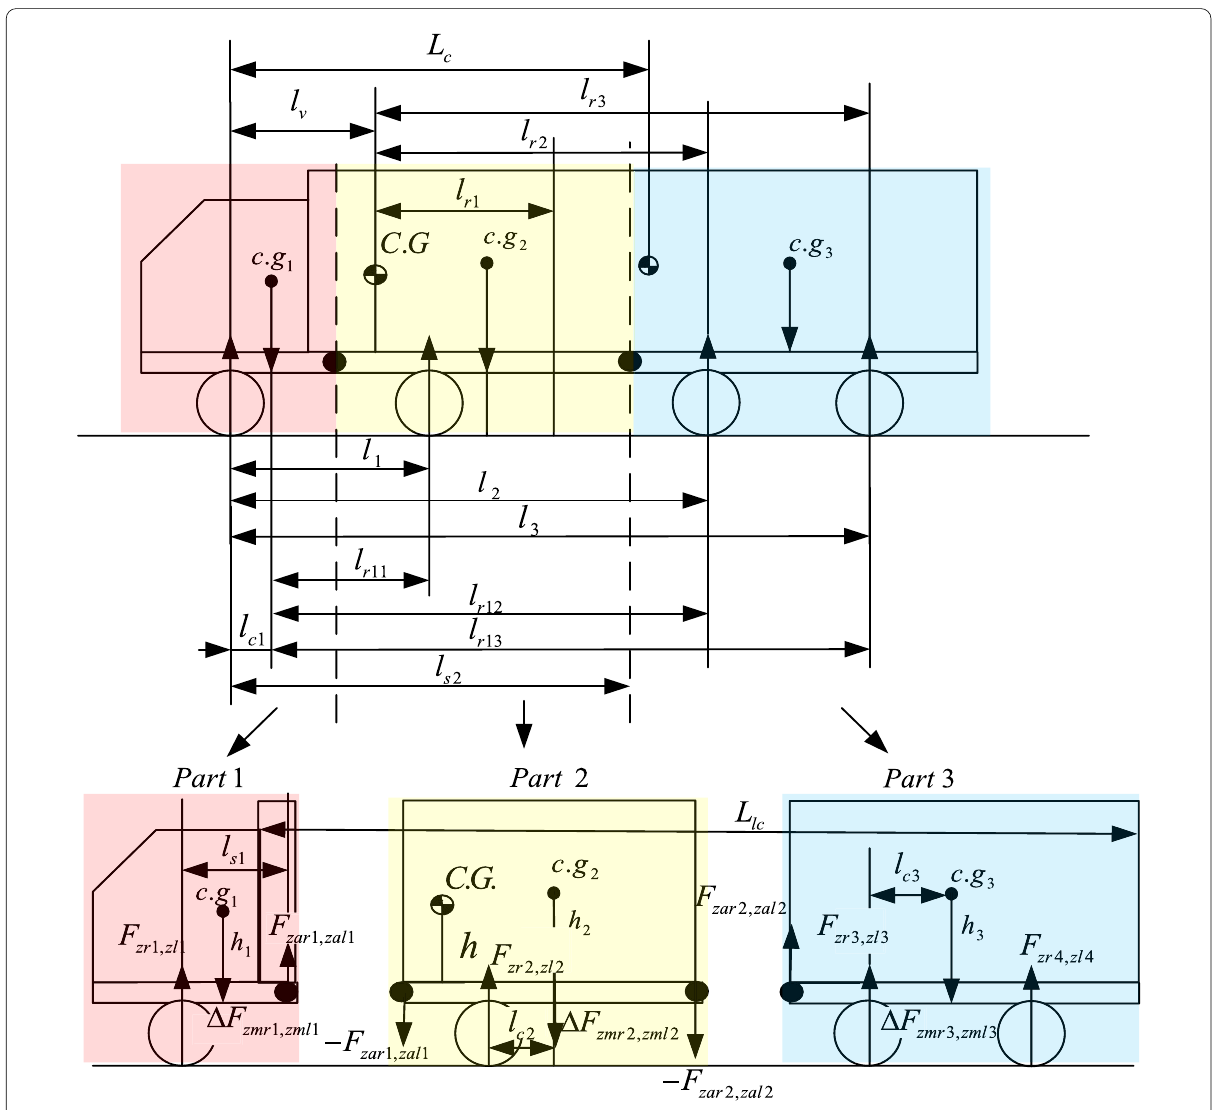
Figure 1 Four-axle truck with three separated